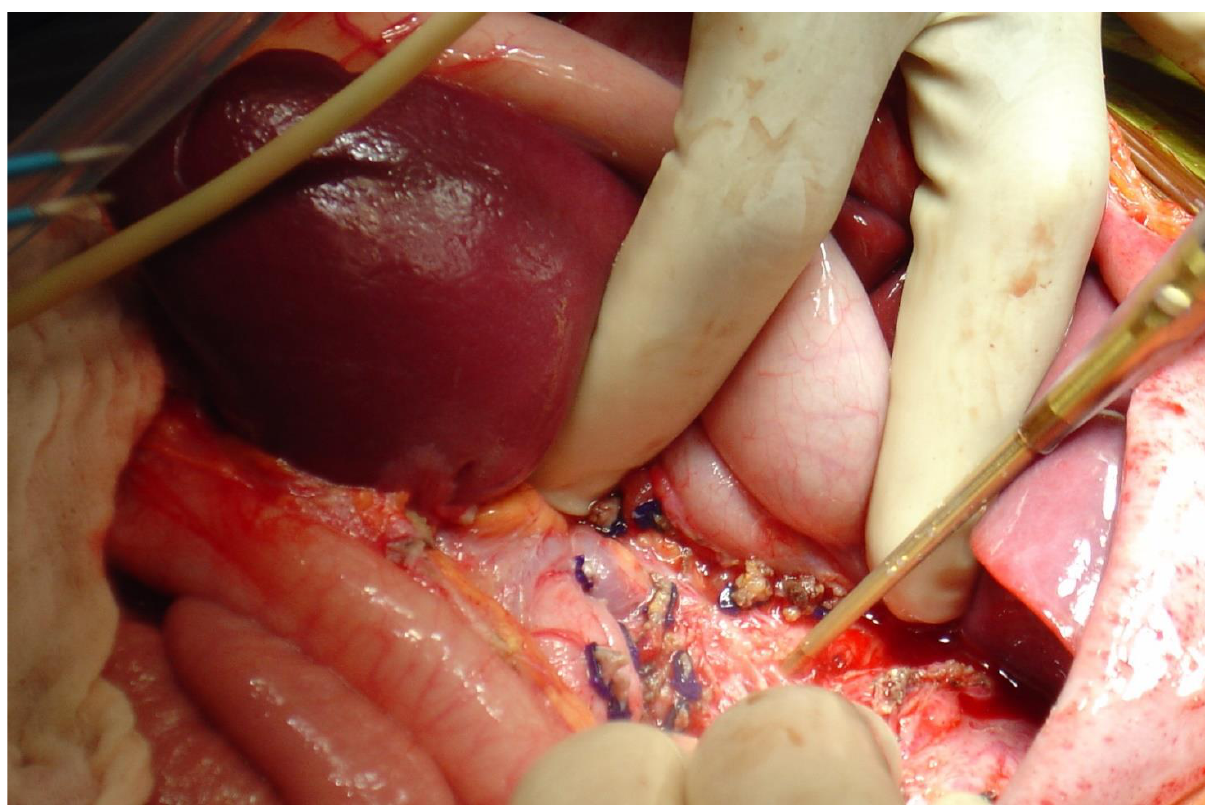
Figure 2. Intraoperative findings: splenic mobilization and cava vein dissection with the CUSA.